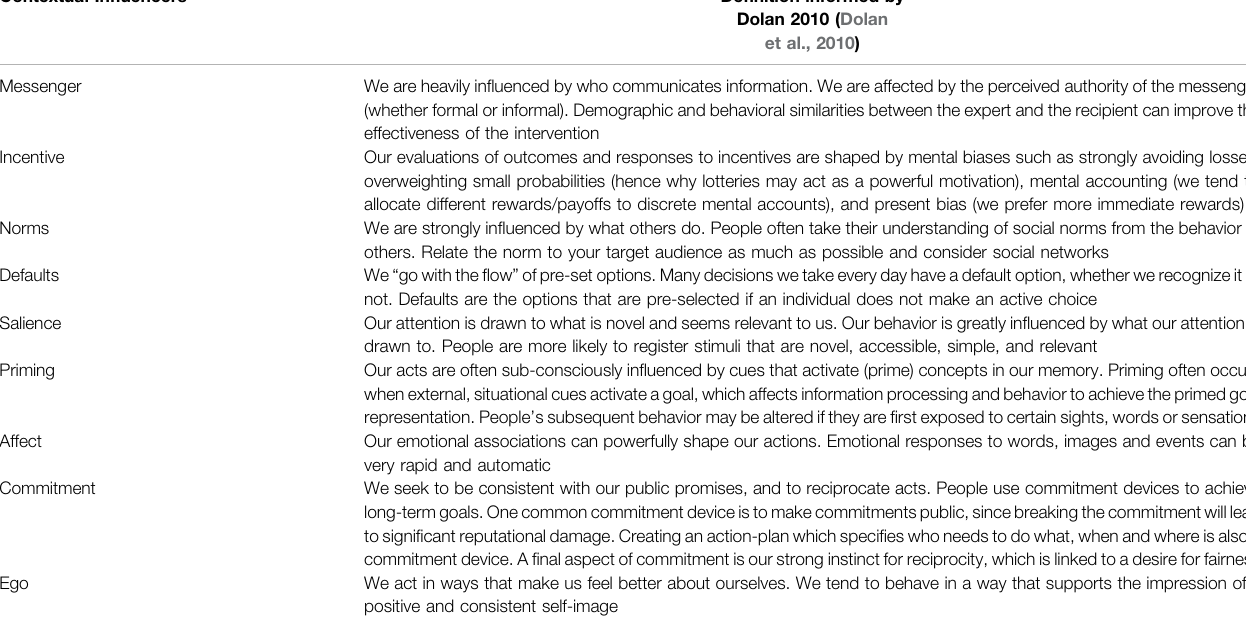
Figure 1 . For instance, the “ knowledge ” determinant is linked